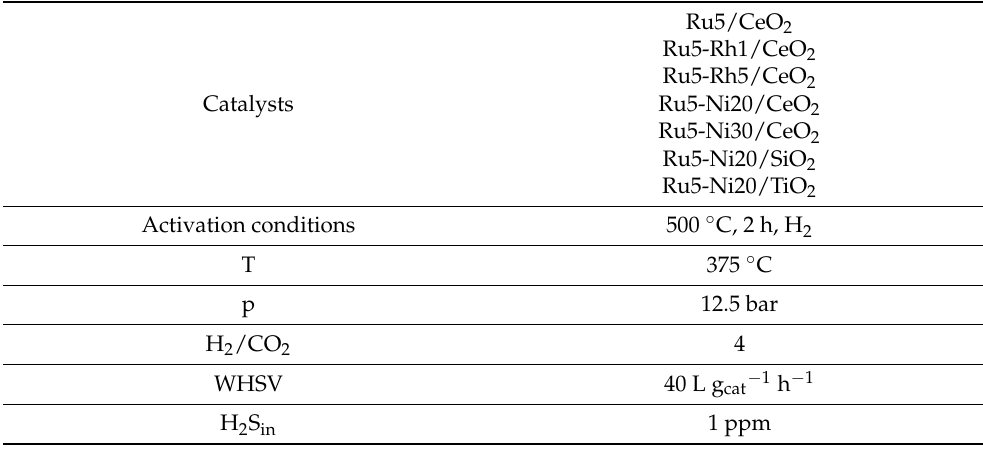
Table 18. Catalysts and reaction conditions for experiments on H 2 S influence in methanation with bimetallic noble metal catalysts on different supports